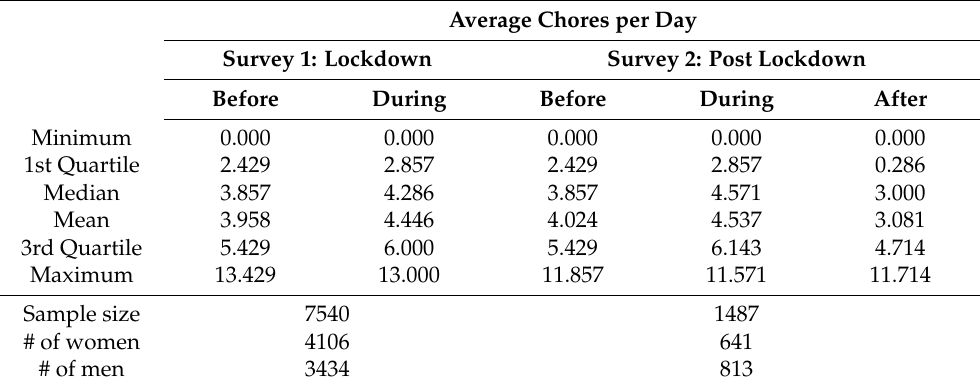
Table 4. Basic statistics of daily unpaid household chores and the care of children and relatives completed per period (relative to lockdown) in both